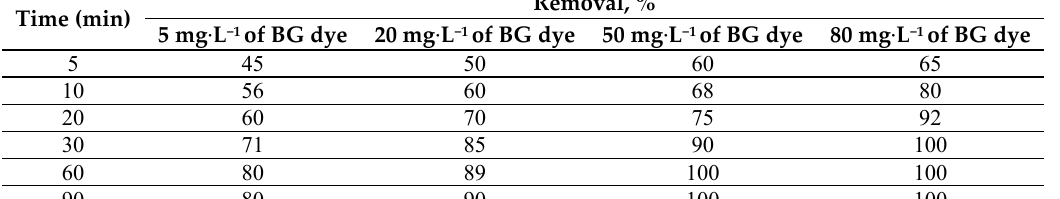
Figure 7. Influence of stirring time on the adsorption of various concentrations of BG dye by Hap/CS nanocomposite.